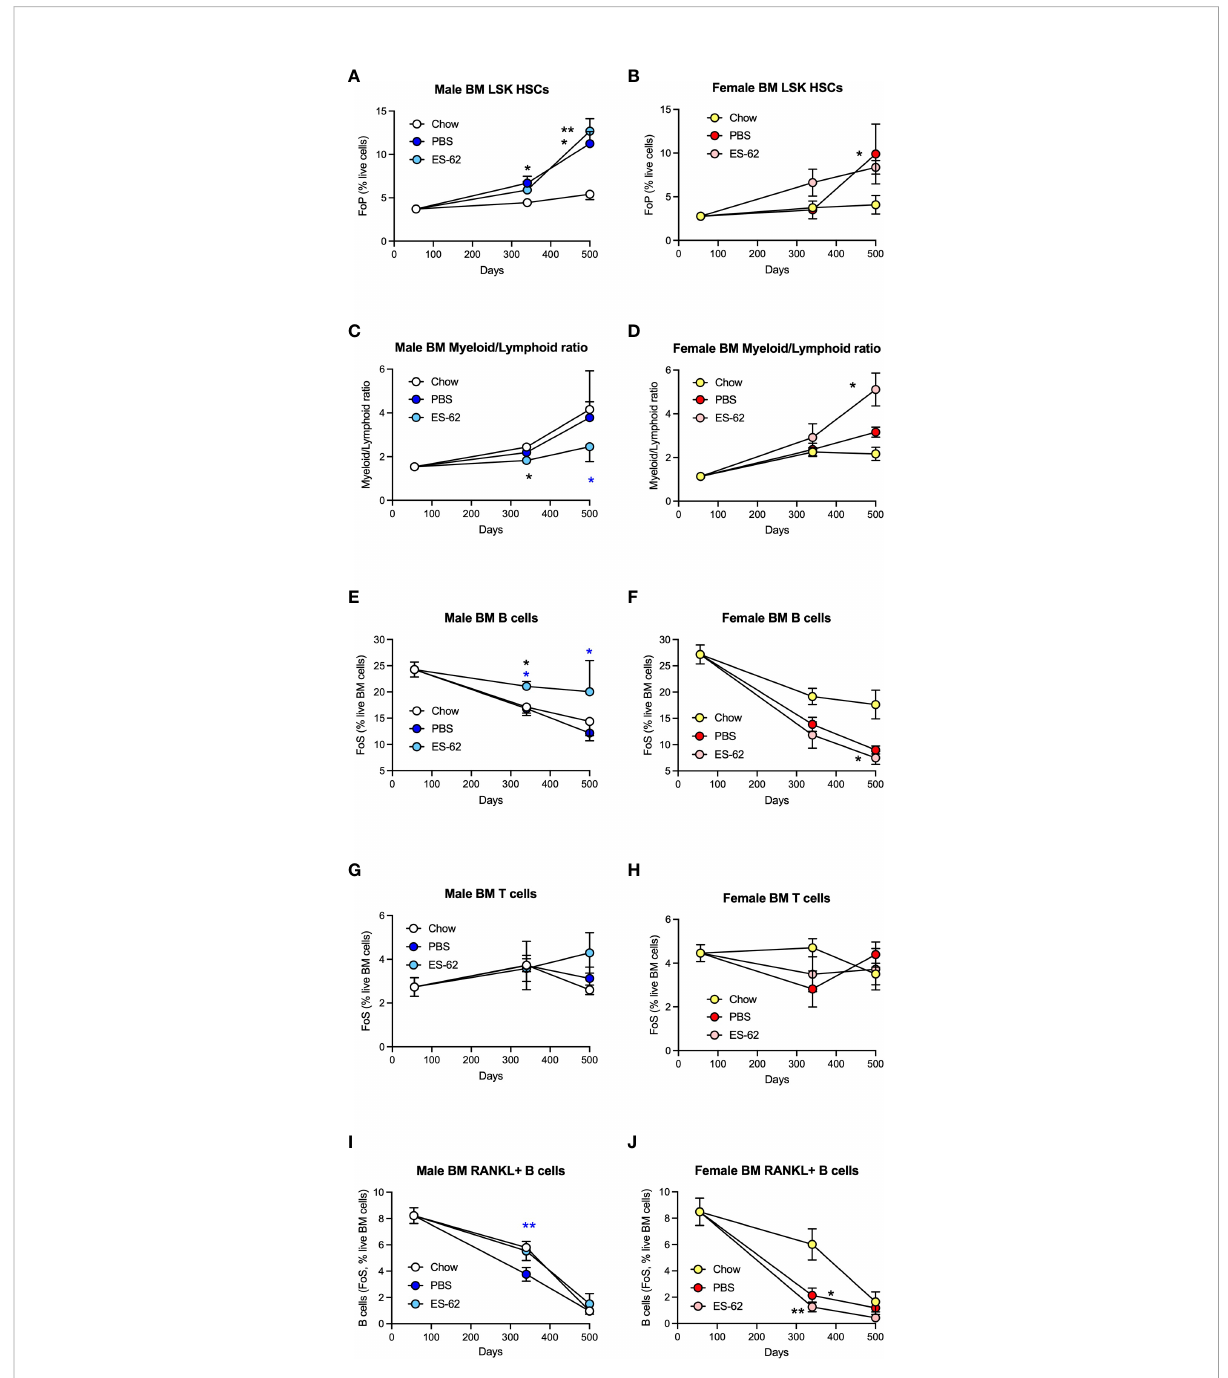
FIGURE 5 ES-62 protects against myeloid/lymphoid skewing and maintains B cell levels in the BM of male HCD-fed mice. The levels of Lin - Sca-1 + c-kit + (LSK) HSC ( A , male; B , female; as % Lin - cells [frequency of precursor (FoP)]) and the ratios of Myeloid/Lymphoid lineages ( C , male; D , female) are shown. The levels of CD19 + B cells (E, F) , CD3 + T cells (G, H) and RANKL + B cells (I, J) were determined as the frequency of single cells (FoS) expressed as % live BM cells at the indicated timepoints in male (E, G, I) and female (F, H, J) mice fed Chow or HCD, the latter cohort treated with either PBS or ES-62. The data are presented as the mean ± SEM values for individual mice in each group, where for male mice, at d56: n=6; d340: Chow, n=6; PBS, n=7; ES-62, n=8; and at d500, Chow, n=5; PBS, n=5; ES-62, n=5 and for female mice, at d56: n=6; d340: Chow, n=6; PBS, n=8; ES-62, n=8; and at d500, Chow, n= 3; PBS, n=5; ES-62, n=6. Signi fi cant differences are indicated by black*=p<0.05 for Chow v PBS or ES-62 in male (A, C, E) or female (B, D, F, J) mice; black**=p<0.01 for Chow v PBS or ES-62 in male (A) and female (J) mice; blue*=p<0.05 for male PBS v male ES-62 (C, E) and blue **=p<0.01 for male PBS v male ES-62 (I)